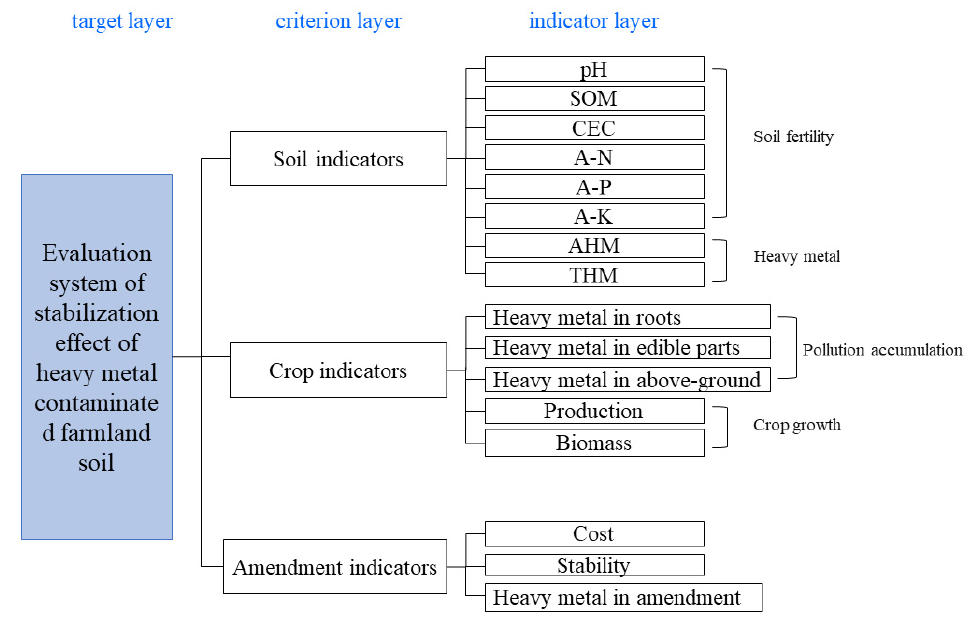
Figure 3. Evaluation index of the stabilization effect of heavy metal-contaminated soil.